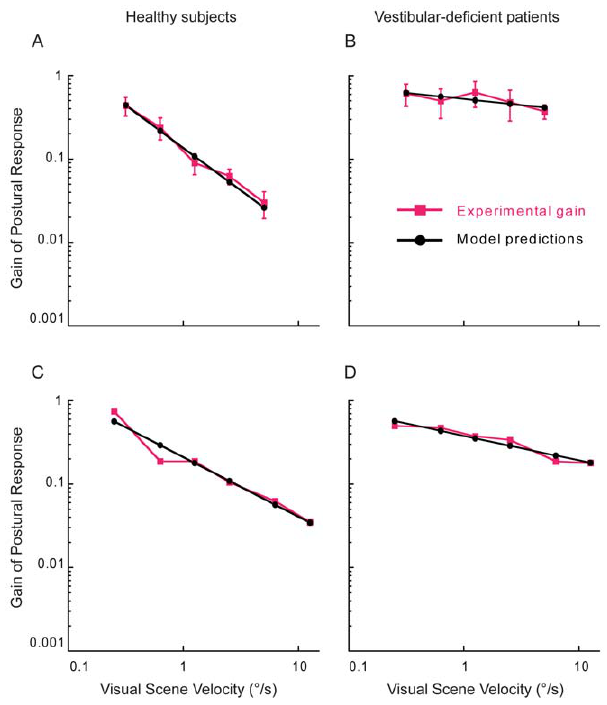
Figure 2. Gain of the postural response of healthy subjects and patients with vestibular loss. (A) and (B) represent the experimental data and model fits of healthy subjects and patients tested in ref. 5 (Mergner et al. 2005). (C) and (D) represent the experimental data and model fits of healthy subjects and patients tested in ref. 4 (Peterka and Benolken